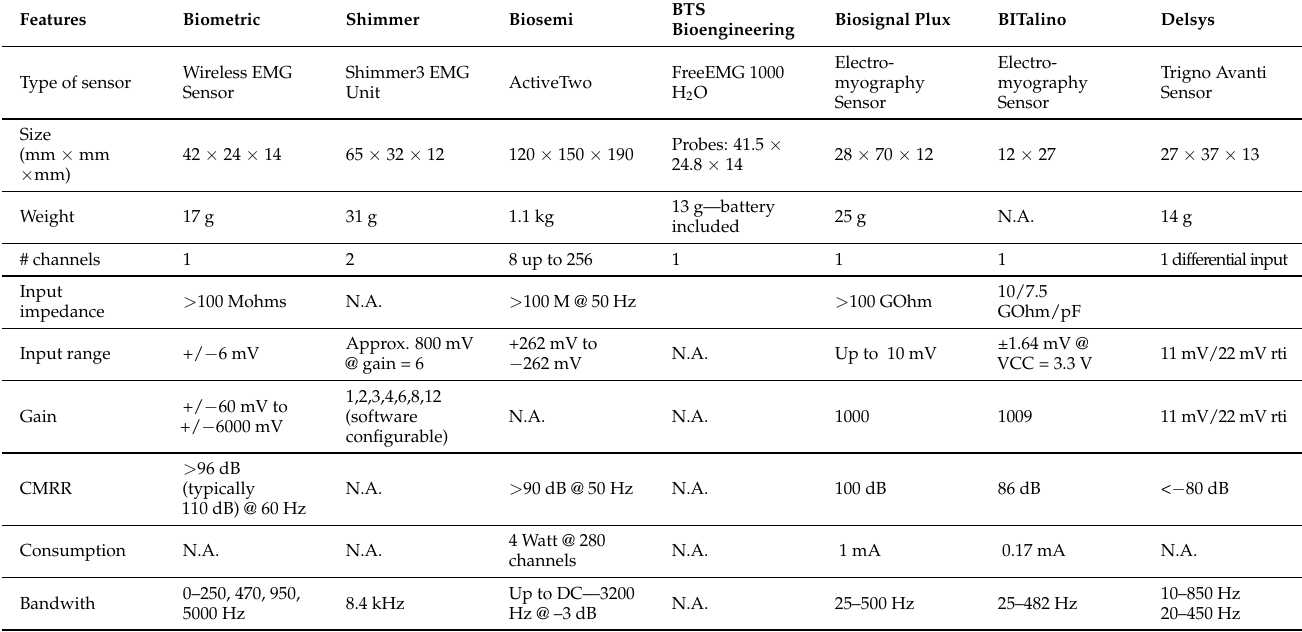
Table 3. Main characteristics of the commercial wearable monitoring